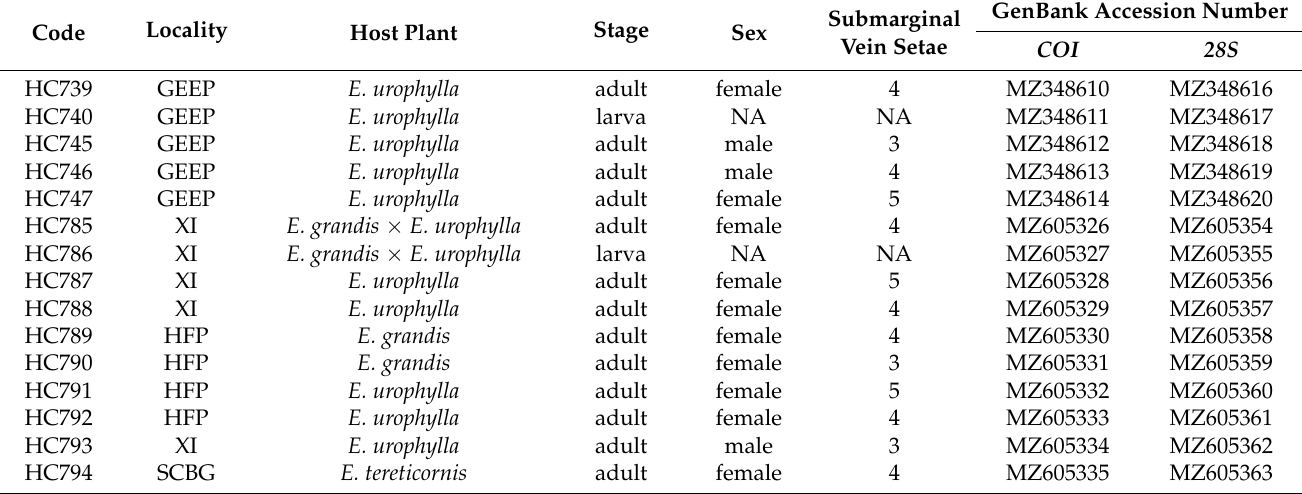
Table 2. Details of specimens sequenced and accession